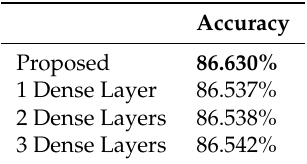
Table 2. The effect of the dense layers.